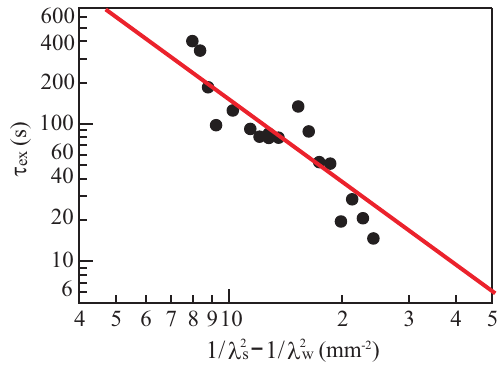
Figure 9. The relationship between τ ex and ( 1/ λ 2 s ) − ( 1/ λ 2 w ) , where τ ex is the time between the application of the organic solvent and the appearance of bumps of 0.2 mm diameter. The quantities λ s and λ w are the wavelengths of the small wrinkles that first appear and the maximum wavelength observed before the wrinkles coalesce, respectively. The closed circles are the experimental results, and the solid line is the fit from Equation (24).